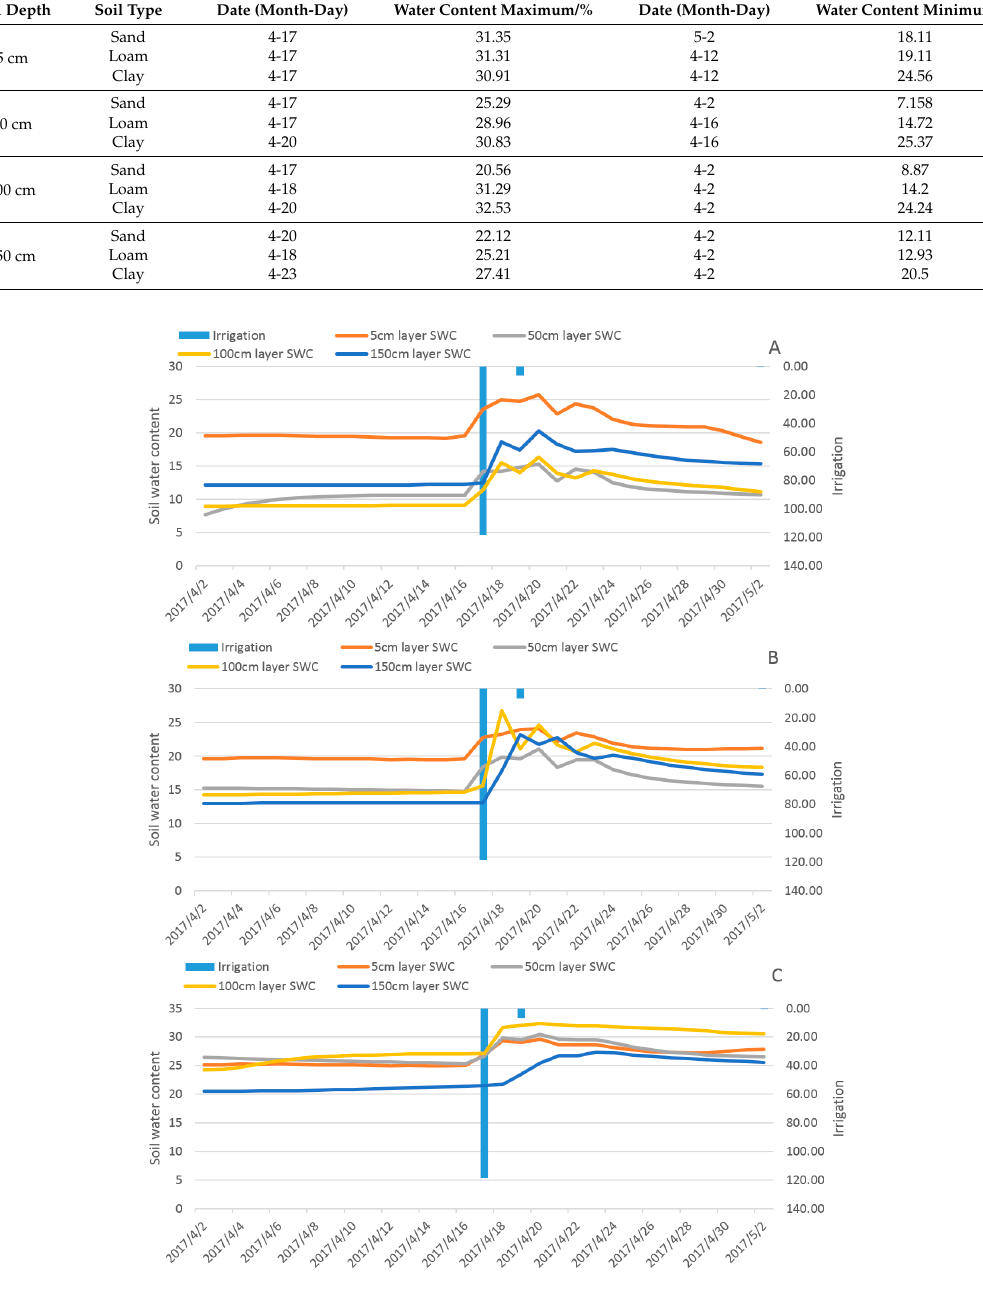
Table 2. Time change peak value of soil volume water content in the study